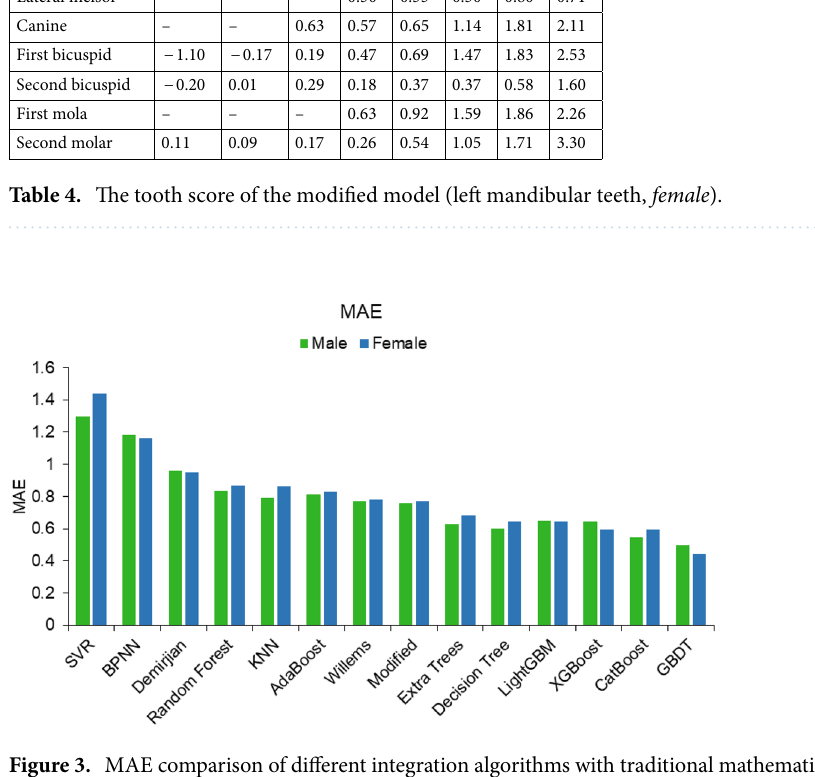
Figure 3. MAE comparison of different integration algorithms with traditional mathematical fitting